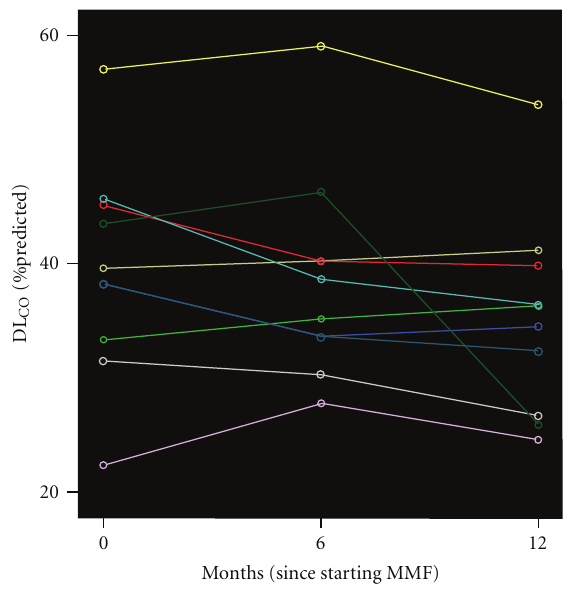
Figure 2: Di ff usion capacity of the lung for carbon monoxide (DL CO ) fluctuations over time for each subject. Each line represents measurements made in a single subject. A time point 0 month indi- cates when MMF treatment was